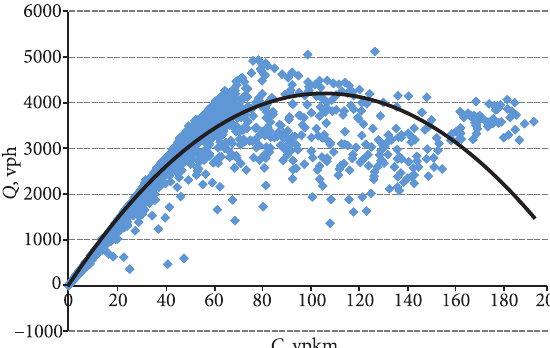
Fig. 5. Relation of traffic volume and traffic flow